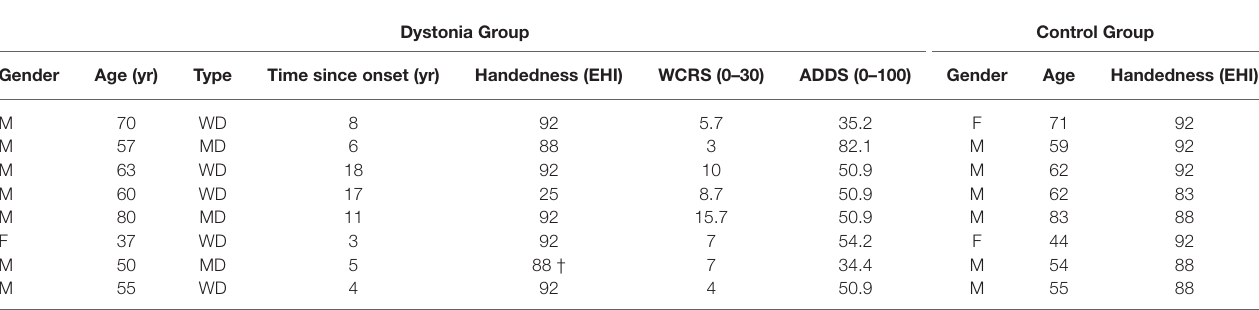
TABLE 1 | Characteristics of people with dystonia and controls .